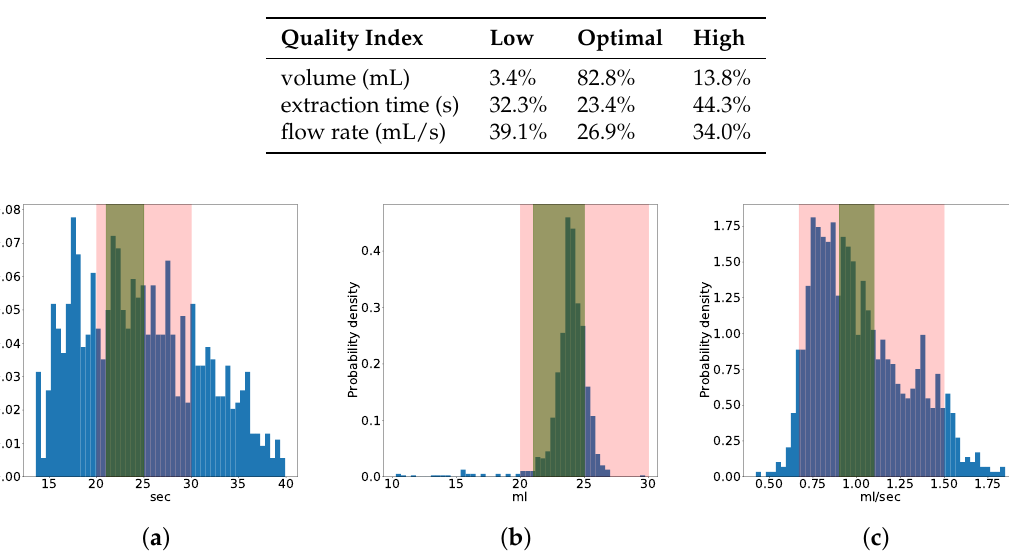
Table 5. Data-driven quality thresholds. Distribution of samples in the dataset.